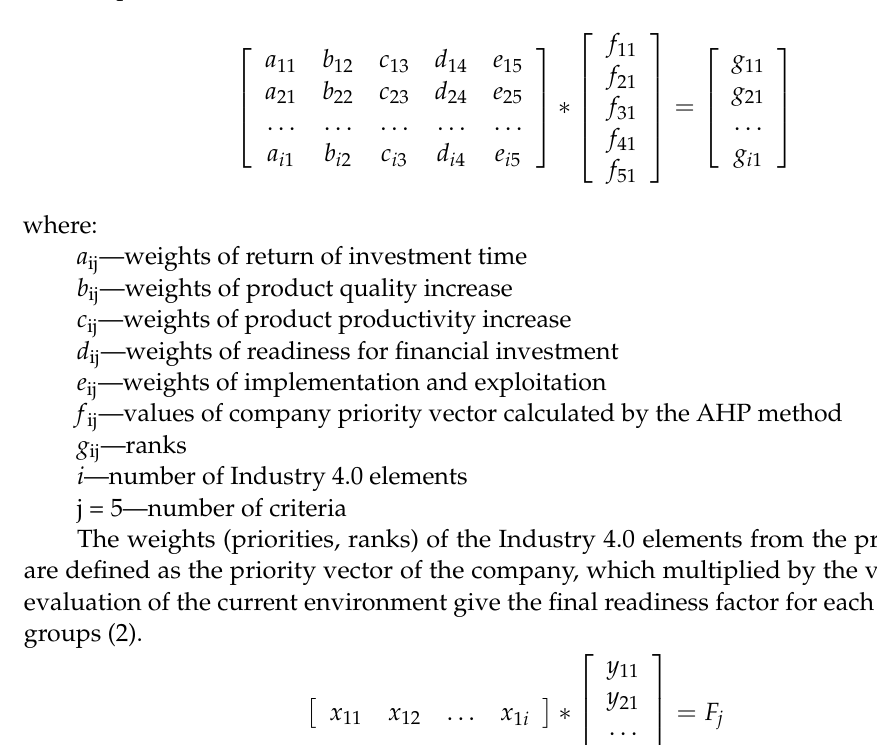
Figure 3. Structure of the implementation model for Industry 4.0 elements oriented to process plan- ning.